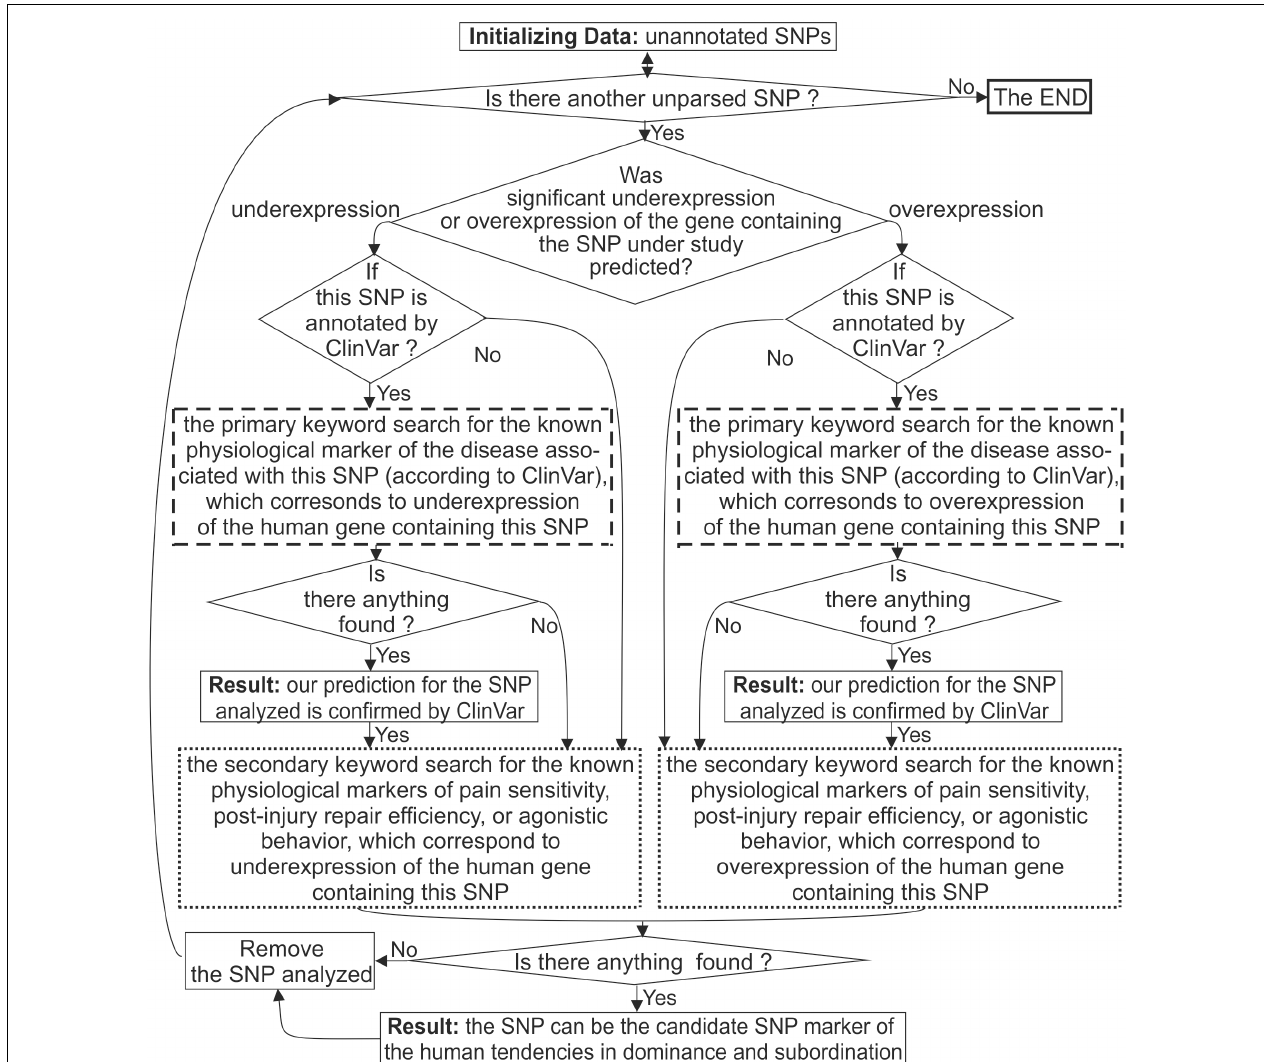
FIGURE 1 | A flow chart of the keyword search for the SNPs of the human neuron-related genes. Dashed boxes depict the primary keyword search for the diseases associated with the analyzed SNP by database ClinVar (Landrum et al., 2014). The dotted boxes depict the secondary keyword search for the known physiological markers of human social behavior, which correspond to the alteration of the gene expression in the case of the SNP being